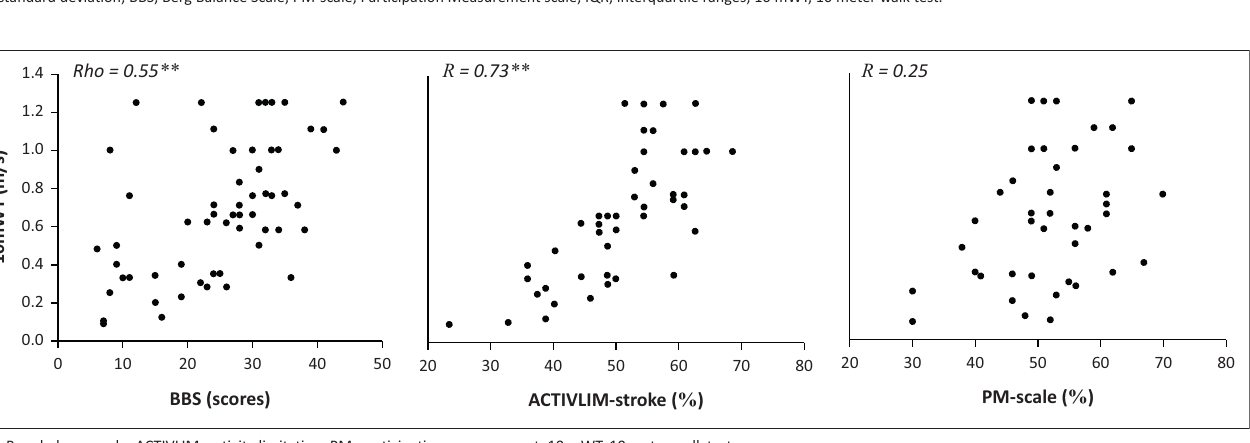
FIGURE 2: Association between walking speed and balance (Berg balance scale scores), activity limitation (stroke scale) and social participation (participation measurement-scale).